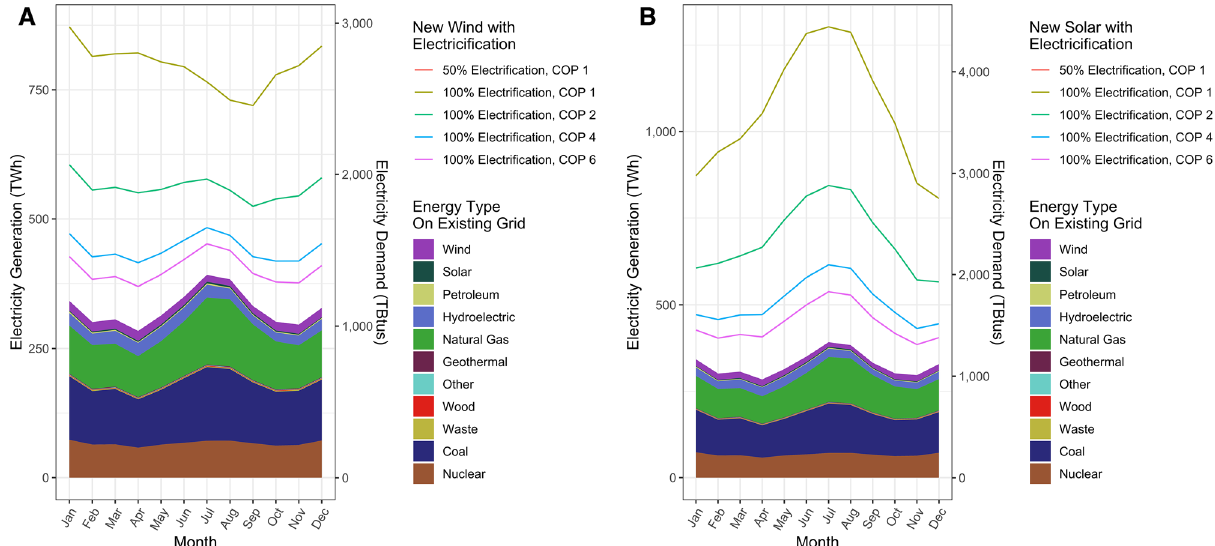
Figure 6. Additional renewable electricity needed to meet building electricity demand under different building electrification scenarios. ( A ) Shaded areas represent current (March 2010–February 2020) electricity generation, and lines represent the additional wind generation necessary to meet new demand under different building electrification scenarios if this additional demand were to be met by wind. ( B ) Shaded areas represent current (March 2010–February 2020) electricity generation, and lines represent the additional solar PV generation necessary to meet new demand under different building electrification scenarios if this additional demand were to be met by solar